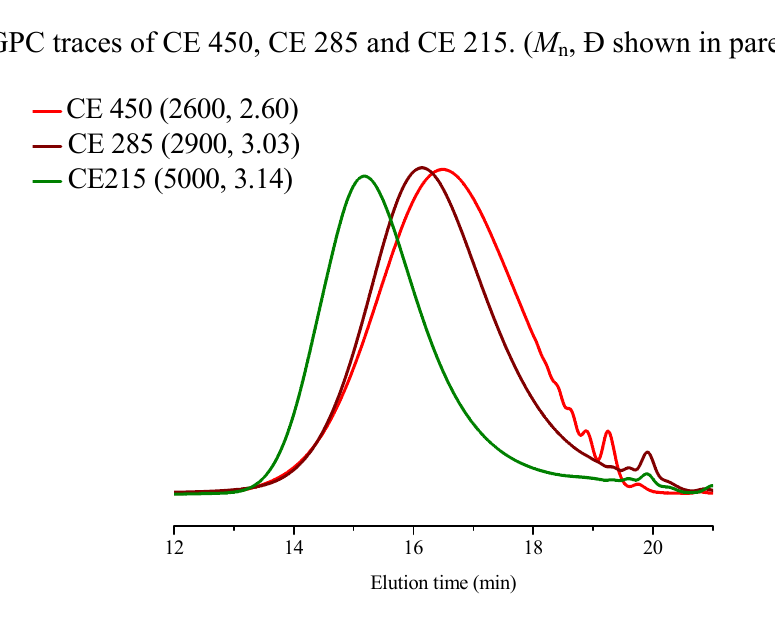
Figure 4. GPC traces of CE 450, CE 285 and CE 215. ( M